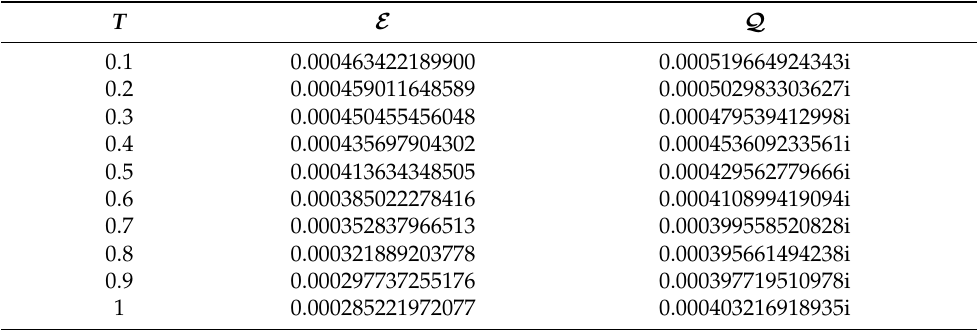
Table 2. Conservation laws at various time levels with M = 32 and ∆ τ = 0.01 for Test Problem 3.